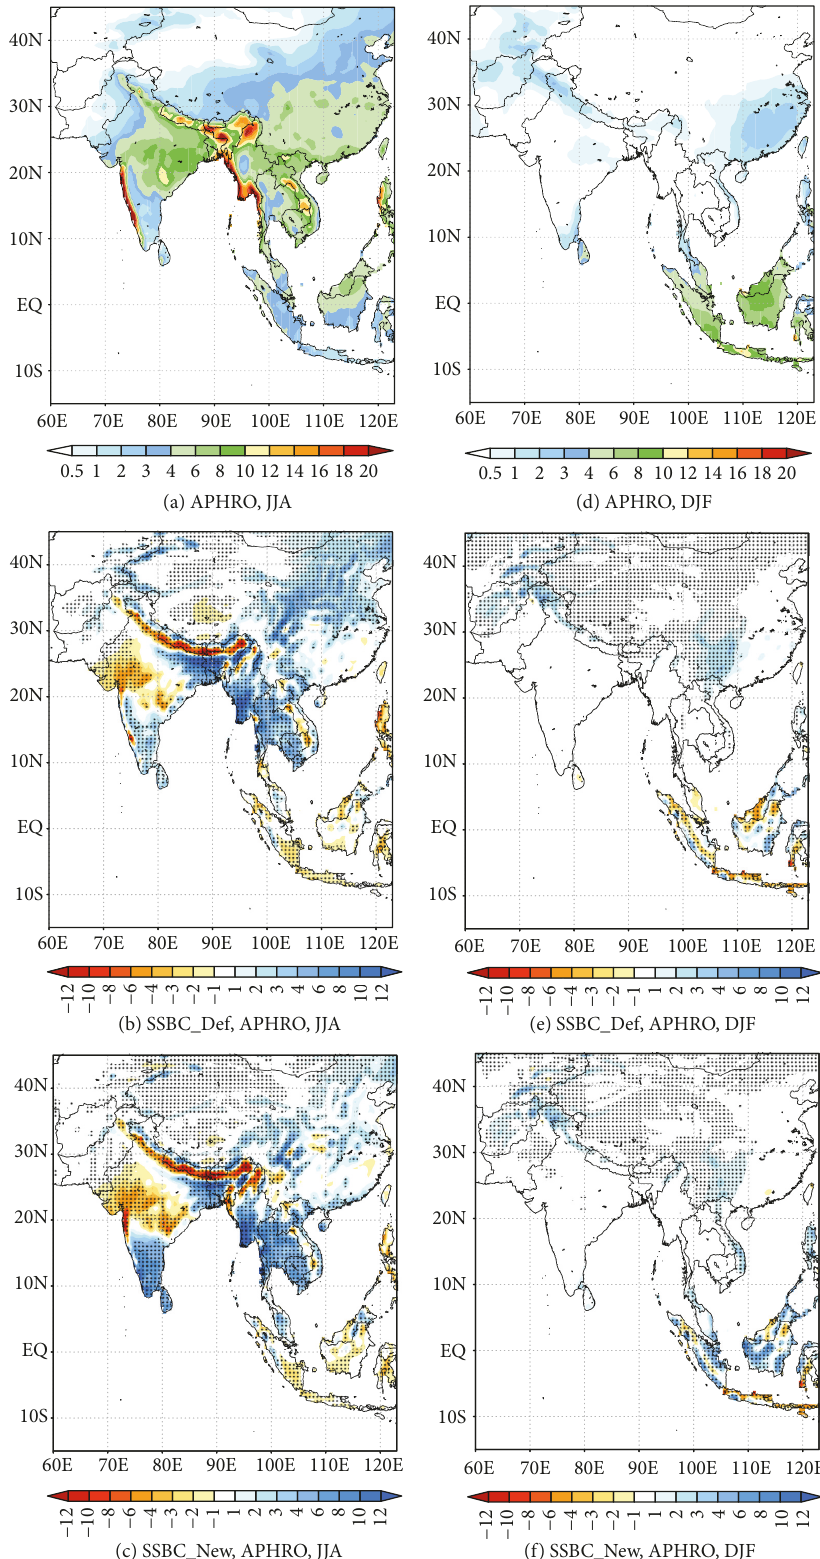
Figure 6: The same as Figures 4(a), 4(d), 5(b), 5(c), 5(e), and 5(f) but with bias relative to APHRODITE 1981–1990 surface precipitation (mmd −1